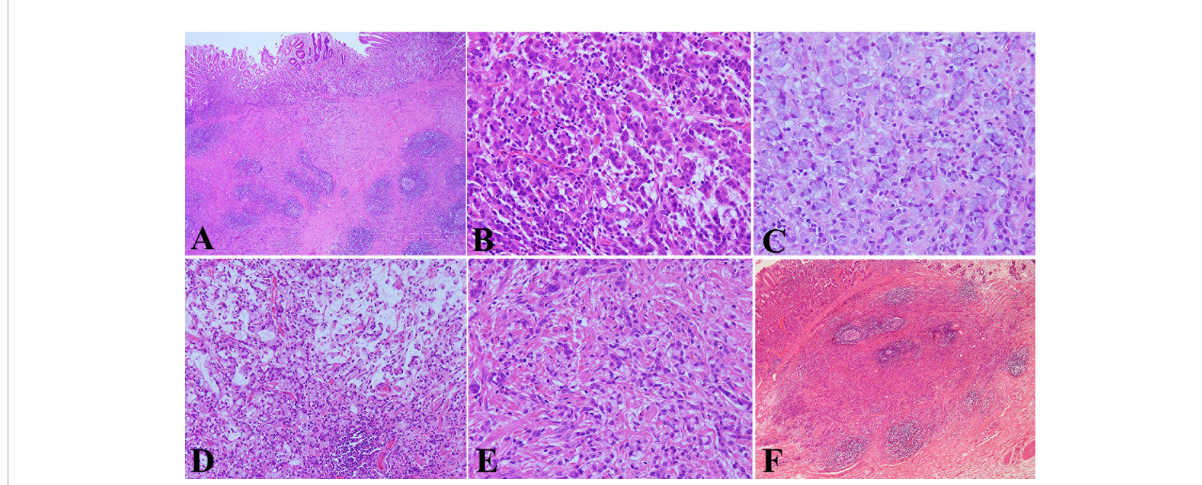
FIGURE 3 Pathological features of HAS by hematoxylin & eosin (HE) staining. (A) The in fi ltration of cancer tissue was limited to the mucosa and submucosa and reached the deep layer of the submucosa. The mucosal surface was almost covered by non-neoplastic epithelium (HE, ×40 magni fi cation). (B) Some cancer cells were arranged in the form of irregular nests, cords, or micro glandular tubes. The cells were large and cubic in size, rich and eosinophilic in the cytoplasm, and with round or oval nucleus, binucleate and small nucleoli, and hepatocyte-like appearance (HE, ×400 magni fi cation). (C) Some cancer cells displayed the form of a signet ring and distributed diffusely (HE, ×400 magni fi cation). (D) There was mucus formation in the interstitium of some signet ring cells, the signet ring cells fl oated in mucus (HE, ×200 magni fi cation). (E) The different forms of cancer cells were interlaced with each other (HE, ×400 magni fi cation). (F) In the submucosa, the stromal fi brous tissue of the cancer obviously proliferated to form a nodular shape with a clear boundary, and the lymphocyte focally in fi ltrated and formed lymphoid follicles (HE, ×40 magni fi